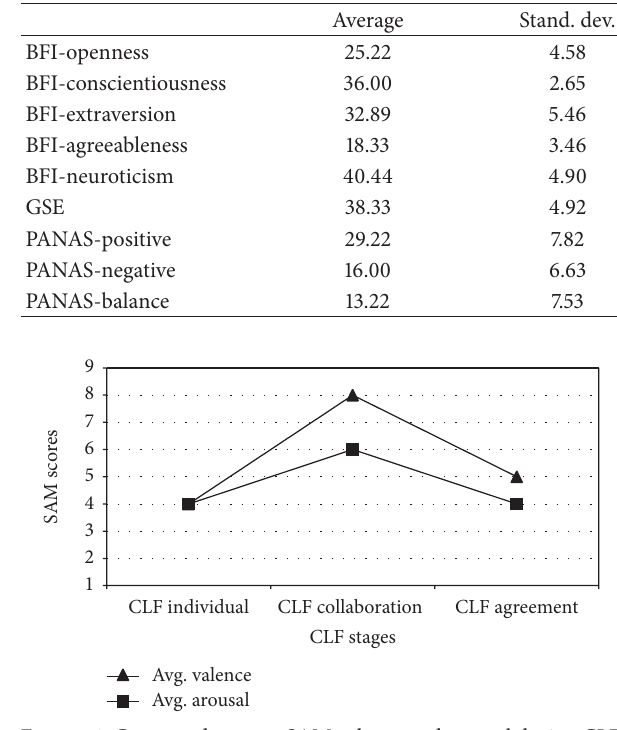
Figure 4: Computed average SAM valence and arousal during CLF interaction